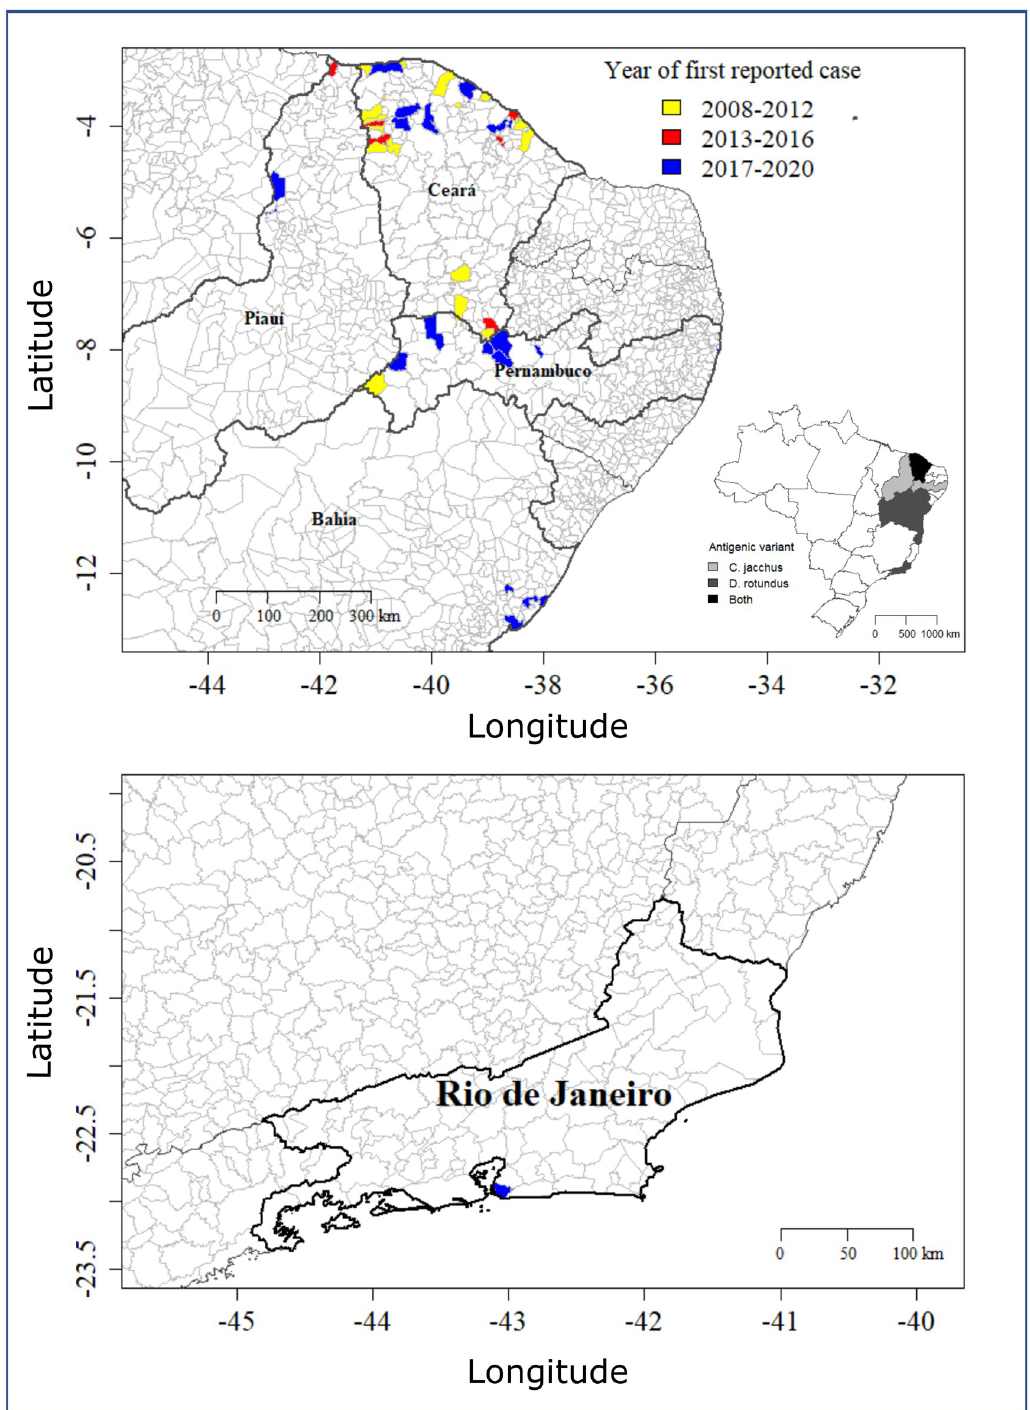
Fig 2. Spatial distribution of outbreaks of rabies in Callithrix jacchus in Brazil. (Top) The main figure shows municipalities of northeast states that have reported an outbreak since 2008, with colors representing the interval of time when the first outbreak was reported at each municipality since 2008. Inset figure shows states reporting cases, with colors representing whether states have reported rabies cases in C . jacchus belonging to the specific antigenic C . jacchus variant, the D . rotundus variant (AgV3) or both. (Bottom) Municipality location of the rabies case reported in the state of Rio de Janeiro belonging to the D . rotundus variant. Country, region and district maps were obtained from the GADM (http://www.gadm.org//) database, freely-available